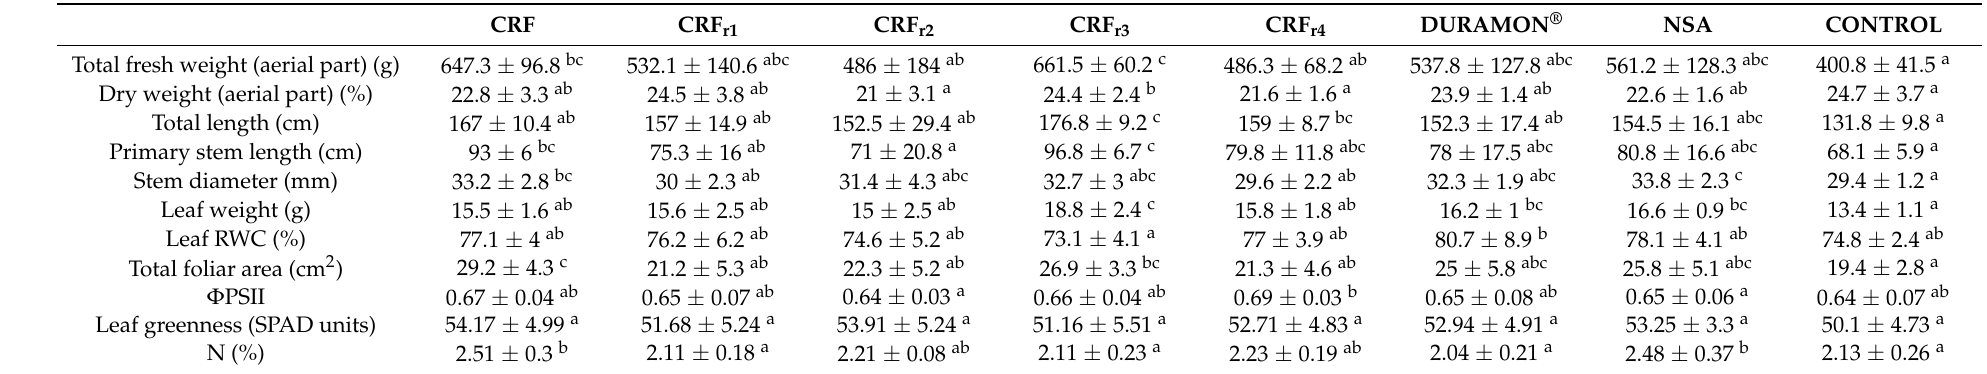
Table 1. Effects of fertilizer treatments (CRF and their reductions, DURAMON ® , NSA) on the growth, the effective quantum yield of photosystem II ( Φ PSII), leaf greenness, and N content compared to CONTROL, in the microscale experiment (CRF, DURAMON ® and NSA: 350 kg ha − 1 ; CRF r1 : 315 kg ha − 1 ; CRF r2 : 280 kg ha − 1 ; CRF r3 : 245 kg ha − 1 ; CRF r4 : 210 kg ha − 1 ). Values are means ± SD (data on growth parameters, n = 4 plants; data on photosynthetic and nutritional parameters, n = 16 plants) at the phenological stage of 8 nodes.